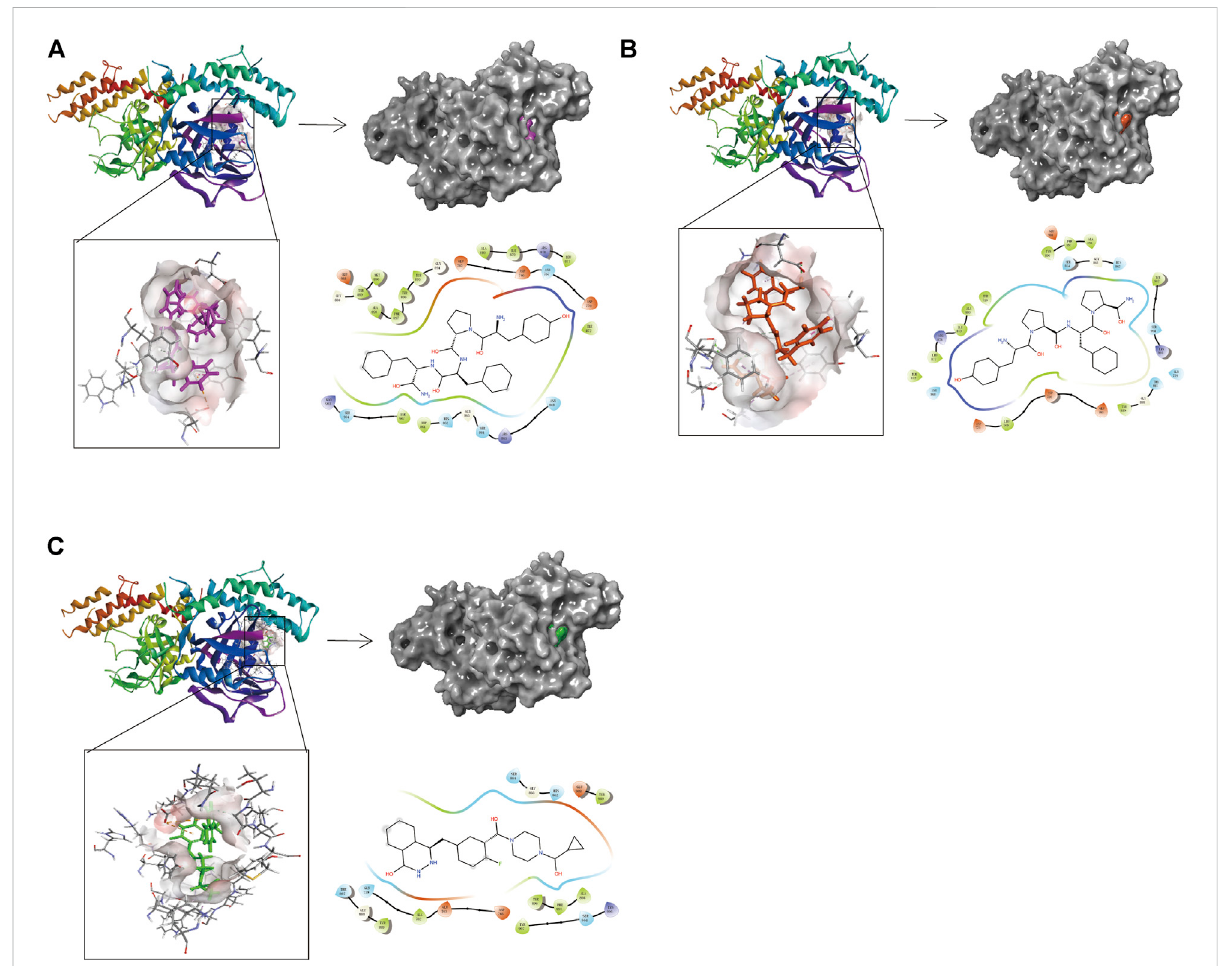
FIGURE 6 The3Dand2Dschematicdrawing ofinteractions between ligands andPARP-1byDS 4.5,andSchrodinger.The surfaceofthebindingarea was added; blue represented positive charge; red represented negative charge; ligands were shown in sticks; the structure around the ligand-receptor junction was shown in thinner sticks. In addition, the surface of the complex was added, purple for ZINC000014951634, orange for ZINC000053057130, green for Lynparza and gray for PARP-1. (A) ZINC000014951634- PARP-1 complex; (B) ZINC000053057130- PARP-1 complex; (C) Lynparza -PARP-1